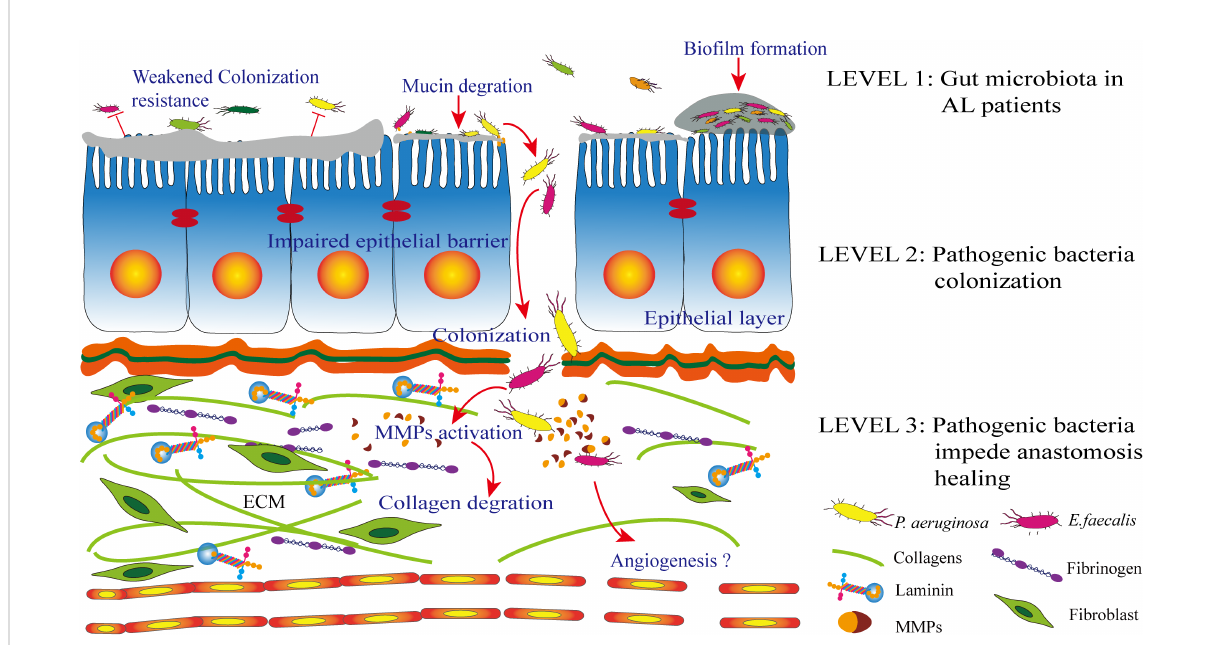
FIGURE 2 Level 1 : patients with anastomotic leak (AL) are characterized by an altered gut microbiota. Level 2 : the wound healing tissue is a desirable environment for collagenolytic strains. The extracellular matrix (ECM) on the anastomosis site, which includes collagen, fi brinogen, and laminin. Bacterial adhesin proteins are essential for the adhesion process. In addition, pathogen bio fi lm formation and a weakened colonization resistance from commensal bacteria together contribute to this process together. Level 3 : following successful colonization, the pathogen can degrade mucin and inhibit epithelial cell repair. Most importantly, pathogens such as Enterococcus faecalis and Pseudomonas aeruginosa have been identi fi ed to express proteases and then activate matrix metalloproteinases (MMPs), which contribute to submucosal ECM breakdown and lead to